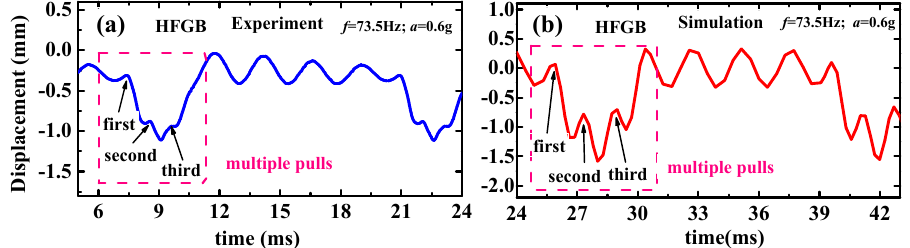
Figure 6. Typical real-time experimental ( a ) and simulation ( b ) displacement of HFGB.